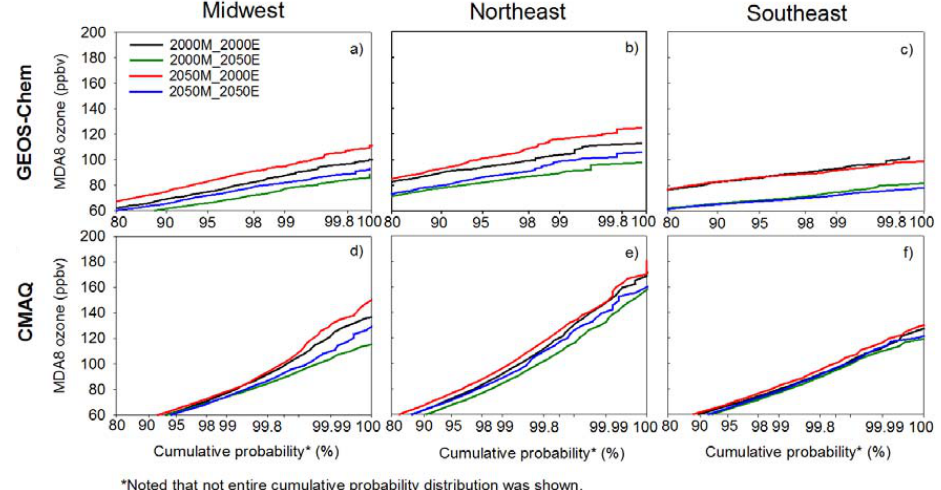
Figure 8. The cumulative probability function of MDA8 ozone for GEOS-Chem and Fig. 8. The cumulative probability function of MDA8 ozone for GEOS-Chem and CMAQ: (a) Midwest for GEOS-Chem, (b) Northeast for CMAQ: (a) Midwest for GEOS-Chem, (b) Northeast for GEOS-Chem, (c) Southeast for GEOS-Chem, (c) Southeast for GEOS-Chem, (d) Midwest for CMAQ, (e) Northeast for CMAQ, and (f) Southeast for GEOS-Chem, (d) Midwest for CMAQ, (e) Northeast for CMAQ, and (f) Southeast for CMAQ. 5